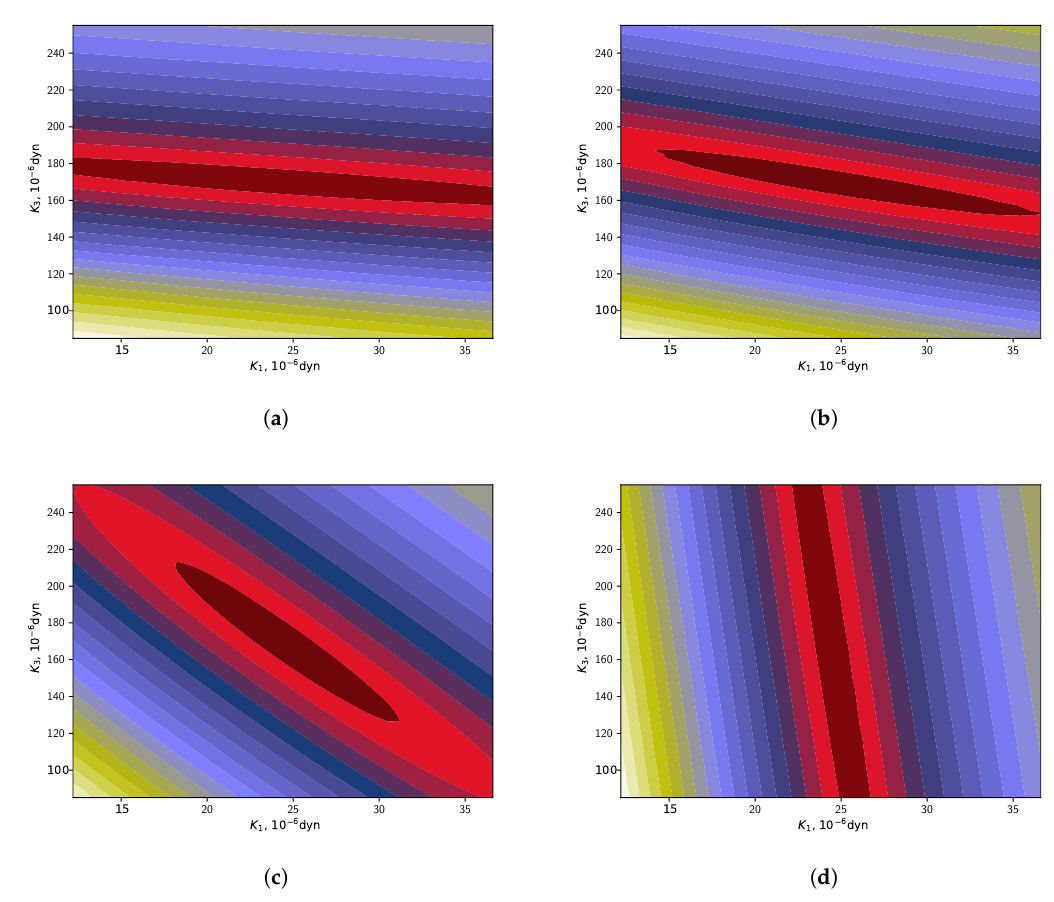
Figure 8. The map for the LSR criterion on K 1 , K 3 for test dependence based on Gd complex for different values of θ 0 : 10 ◦ ( a ), 30 ◦ ( b ), 60 ◦ ( c ), 80 ◦ ( d ). Here, the K 1 and K 3 values are plotted along the axes on the same scale as in Figure